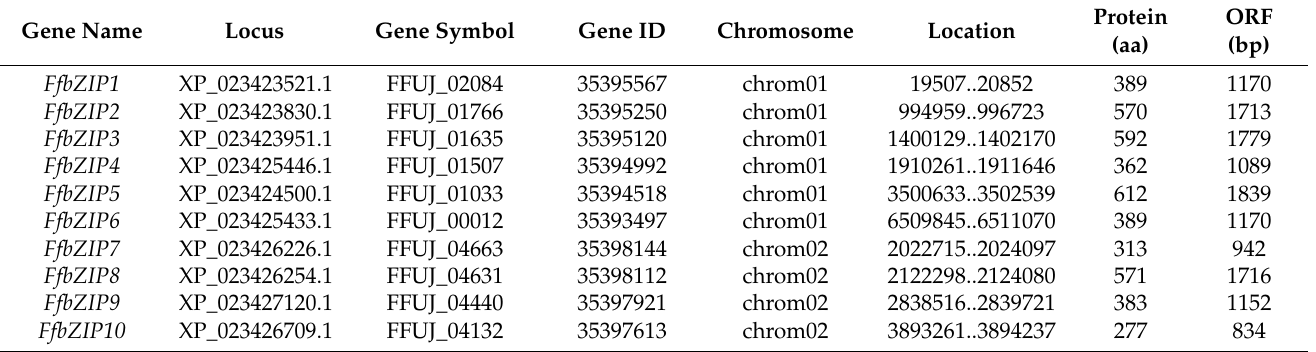
Table 1. List of bZIP TF family identified in the F. fujikuroi